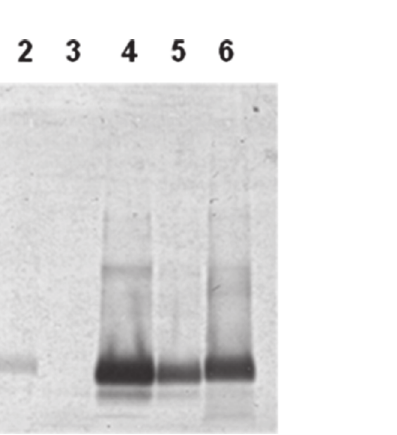
Figure 5. Comparison of the mobilities of PK-resistant PrP derived from BSE-infected bovine brain (original cell inoculate) and M2B cell. Mobility phases of nonglycosylated PrP BSE from the non-infected bovine brain (lane 1), BSE-infected bovine brain (lane 2), non-infected transduced MDBK (MDBK C1 – 2F, passage (p) 7: lane 3), and persistently PK-resistant PrP BSE infected M2B cells (p17: lane 4; p48: lane 5 and p70: lane 6) in Western blotting after sequential treatments with PK and PNGase F. Molecular mass marker (M) in kilodaltons (kDa) is shown on the